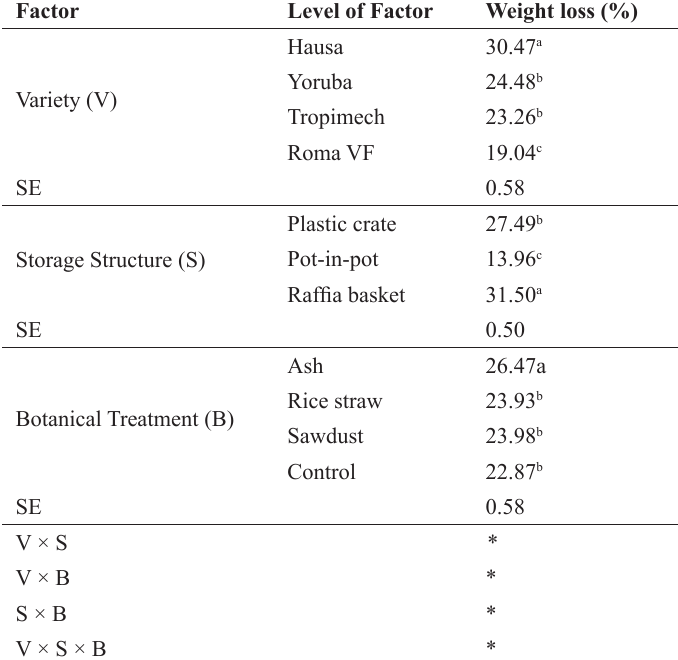
Table 3: Weight loss in tomato fruits and interaction among variety, storage structures and botanical preservatives.